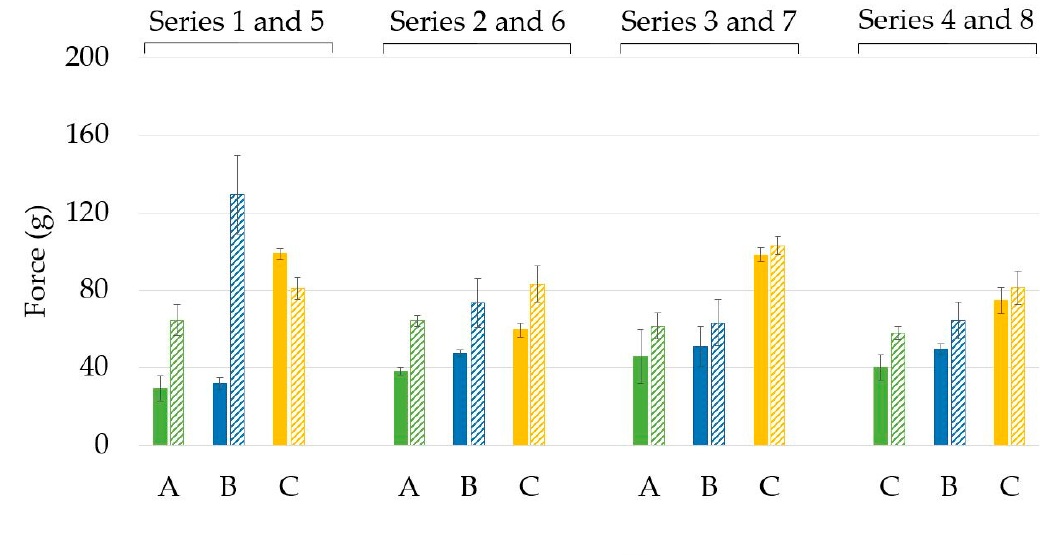
Figure 5. Spreadability of the formulated sunscreens. A: alkenones, B: beeswax, C: cetyl alcohol, 1: OM cinnamate, 2: Homosalate, 3: Octocrylene, 4: Octyl salicylate, 5: OM cinnamate with silicone resin, 6: Homosalate with silicone resin, 7: Octocrylene with silicone resin, 8: Octyl salicylate with silicone resin.